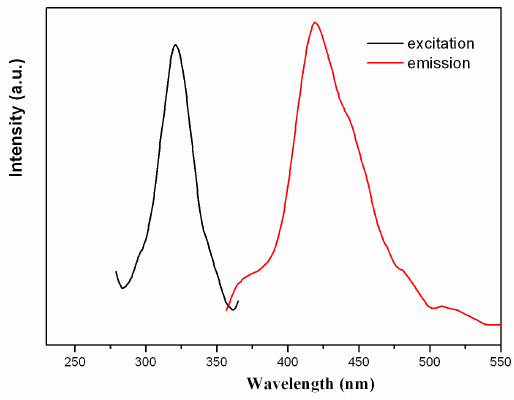
Figure 11. Solid-state photoluminescent spectra of 1 at room temperature.